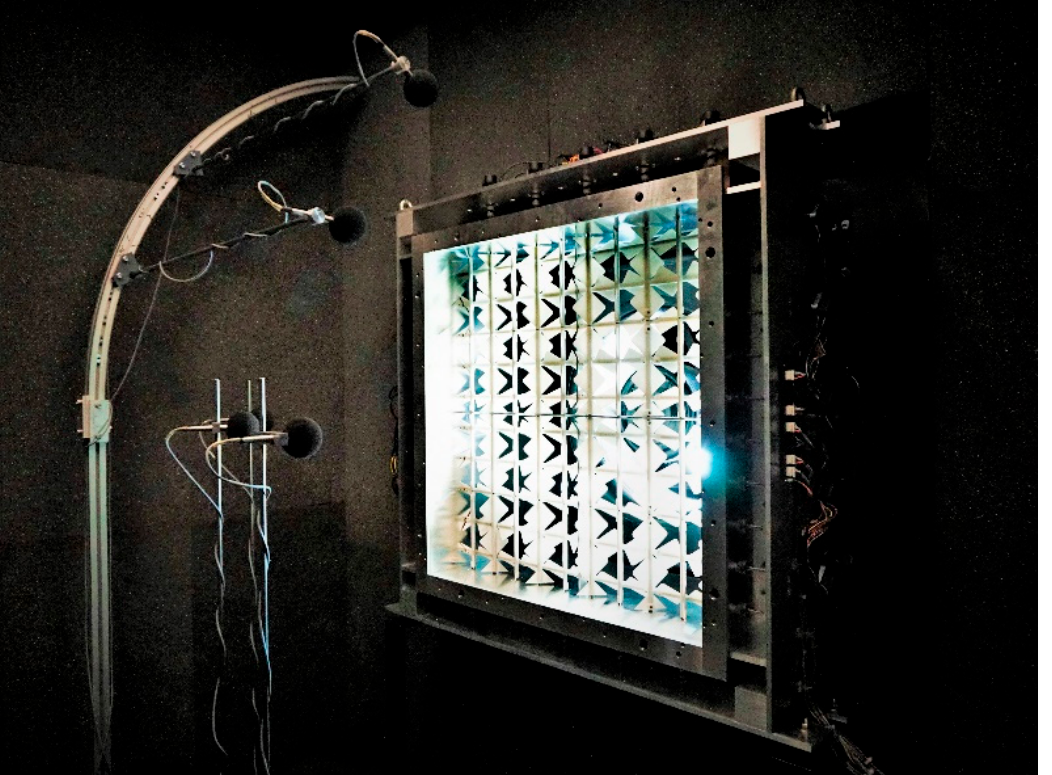
Figure 7. The active trubulence grid inside the anechoic chamber.